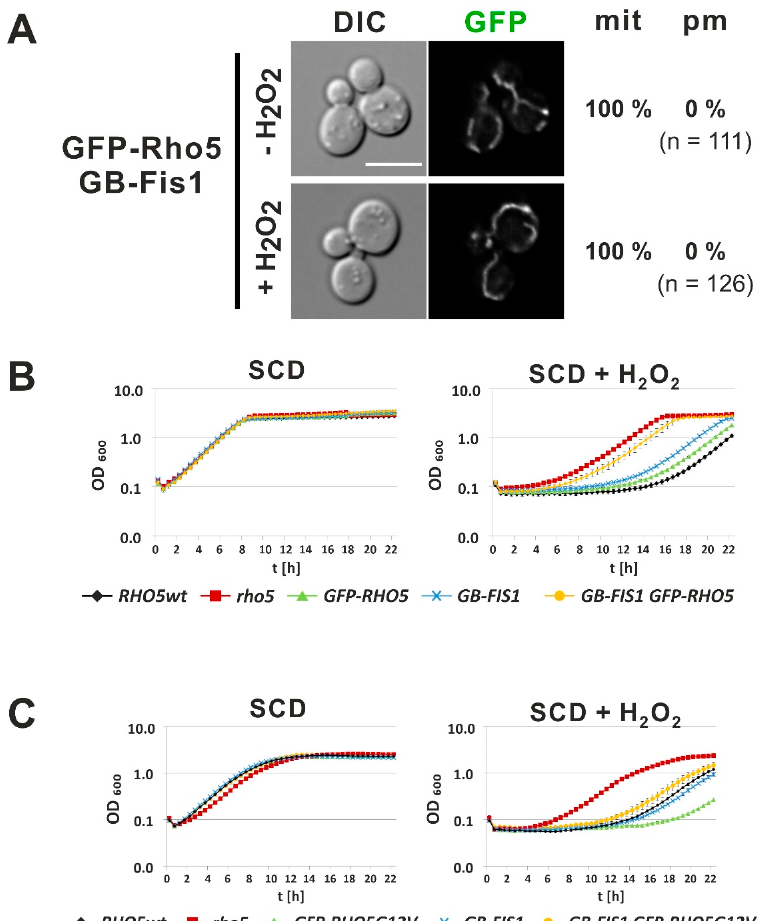
Figure 5. Physiological significance of trapping GFP-Rho5 to the mitochondrial surface. ( A ) Life-cell fluorescence microscopy of strain HOD370-2A, which encodes GFP-Rho5 at its genomic locus, as well as a GFP-binder fusion to the transmembrane domain of the outer mitochondrial protein Fis1, inserted into the leu2-3,112 locus using an integrative plasmid. For detailed descriptions of growth conditions, scales and determination of distribution numbers see legend of Figure 2. ( B ) Comparative growth behavior of strains being wild-type for RHO5 and FIS1 (WT) or carrying different combinations of GFP-RHO5 and GB-FIS1 , as compared to a rho5 deletion. Genotypes of strains employed are given in Table 1. Growth curves were recorded in synthetic medium in the absence or presence of hydrogen peroxide as indicated. ( C ) Comparative growth behavior of strains with an activated GFP-RHO5 G12V allele. Growth curves were recorded in synthetic medium as described in ( B ).